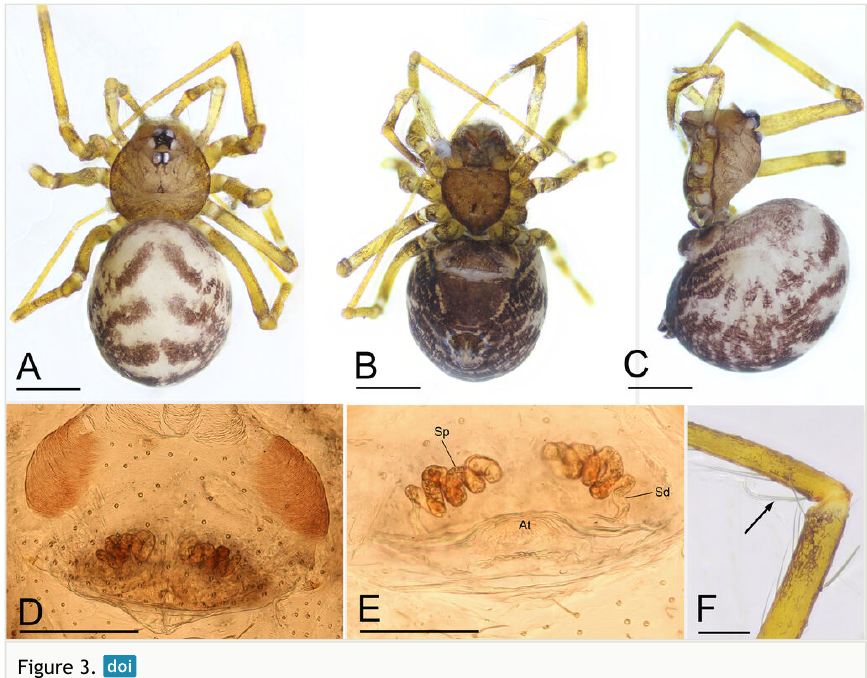
Figure 3. Yueleptoneta dongxing sp. n., paratype female. A habitus, dorsal view; B habitus, ventral view; C habitus, lateral view; D genitalia, ventral view; E genitalia, dorsal view; F metatarsus II, lateral view, arrow shows preening comb. Abbreviations: At = atrium, Sd = sperm duct, Sp = spermatheca. Scale bars: 0.4 mm (A–C), 0.2 mm (D–E) and 0.1 mm